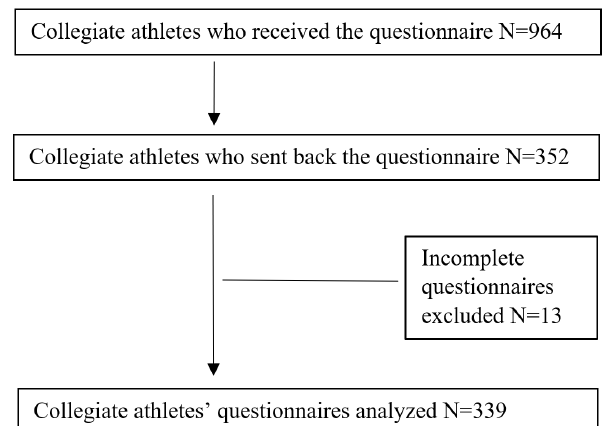
Figure 1. Flow diagram of the study. Table 1. Characteristics of collegiate athletes.